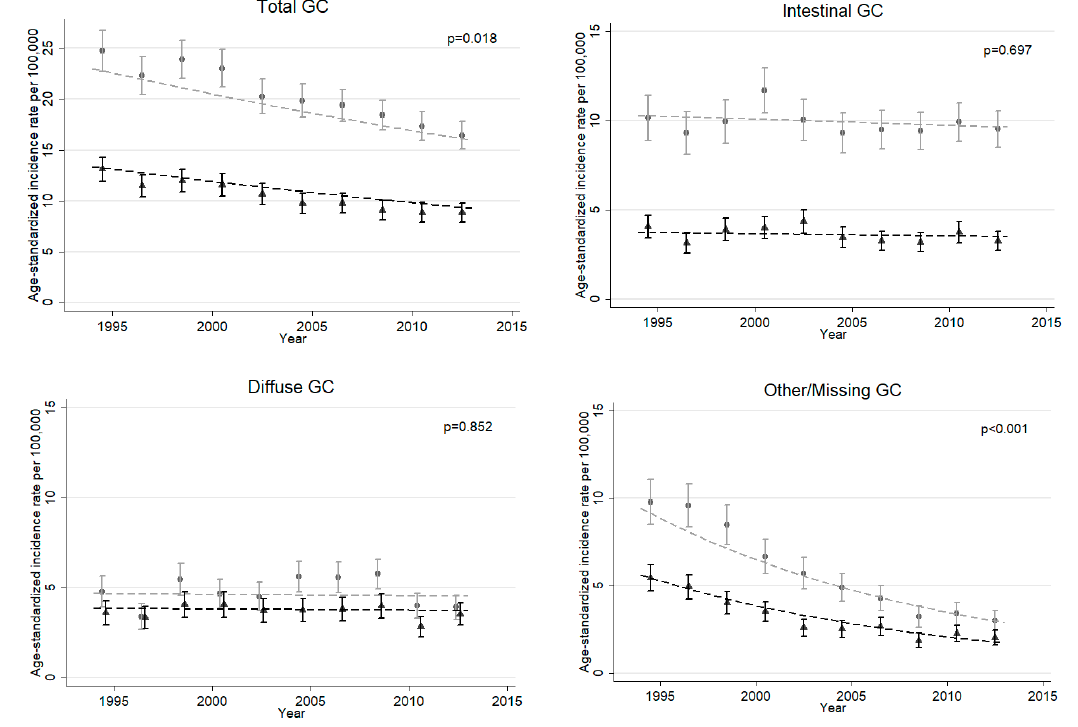
Figure 1. Age-standardized incidence rates (ASR) for each subtype of gastric cancer (GC) according to Laur é n classification in the general Münster population. Plotted for two-year periods, from 1994–1995 to 2012–2013, with 95% confidence intervals. Males marked in gray, females in black. Dashed lines represent time trends modeled using negative binominal regression, with corresponding p-values of linear calendar year effect (rates are standardized with respect to the old European standard population).